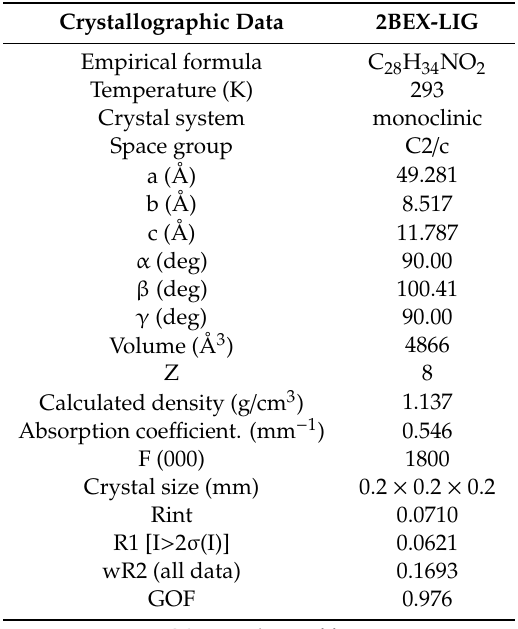
Table 2. Crystallographic data of the 2bexarotene-ligustrazine (2BEX-LIG) co-crystal. Crystallographic